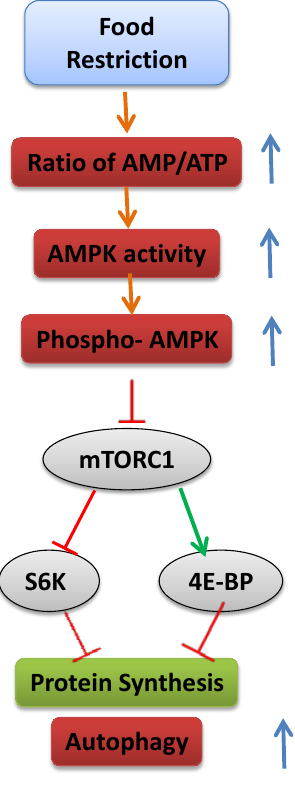
Figure 3. Schematic representation of the mechanism leading to inhibition of mTOR and activation of